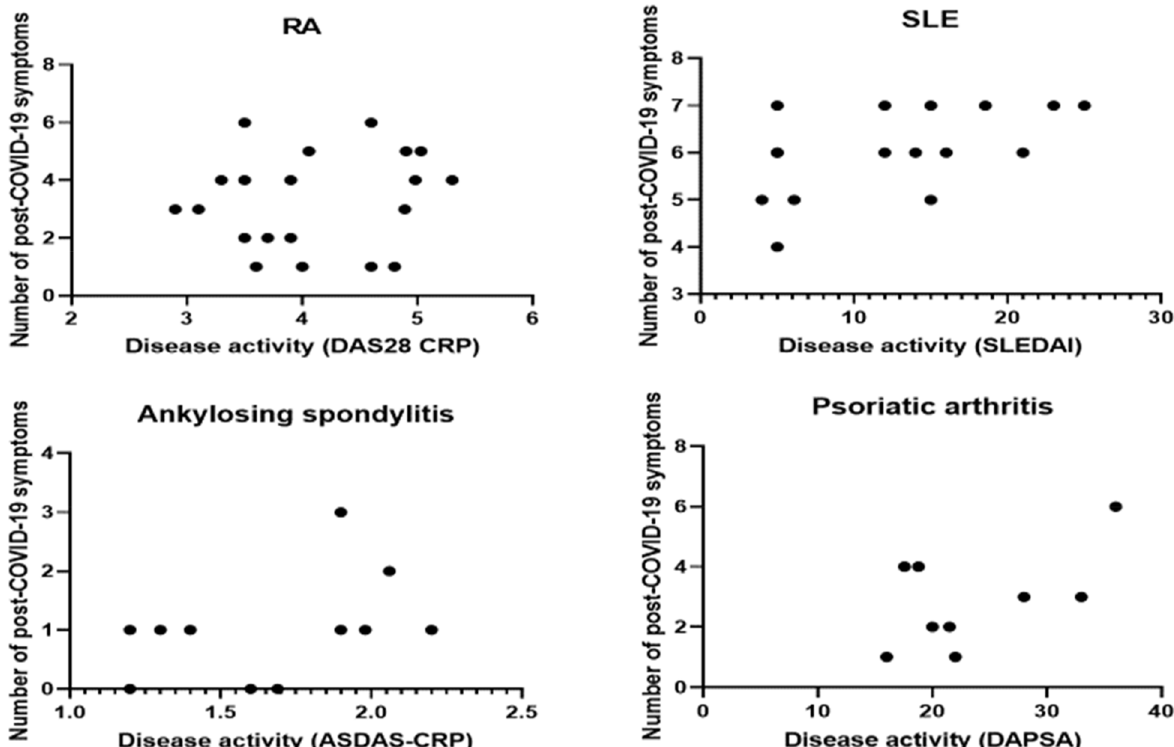
Fig. 2 Non-significant correlations between the number of post-COVID-19 symptoms and disease activity as measured by the disease activity score (DAS28-CRP) in RA, the SLE disease activity index (SLEDAI), the disease activity in psoriatic arthritis (DAPSA), and the ankylosing spondylitis disease activity score (ASDAS) ( r